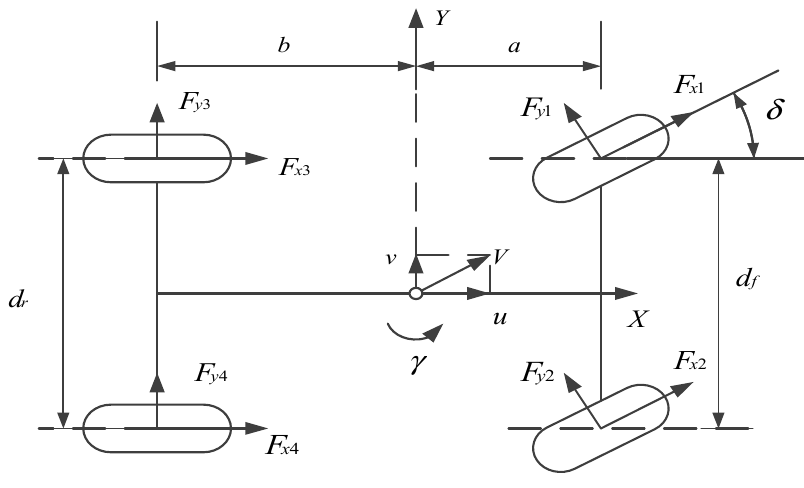
Figure 1. Car dynamics model diagram.